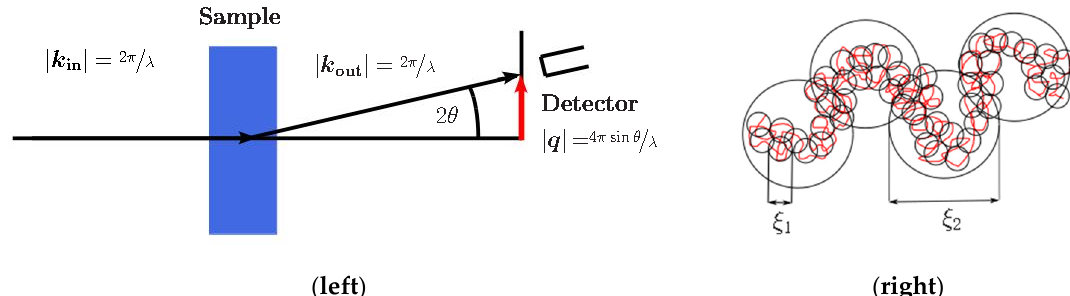
Figure 2. ( Left ) SAXS setting with incident and scattered wave vectors, | k in | and | k out | , respectively, and momentum transfer | q | ; ( right ): correlation length representing the static screening length, ξ 1 , and fractal correlation length for larger domain size, ξ 2 , as determined from Equations (8) and (9).